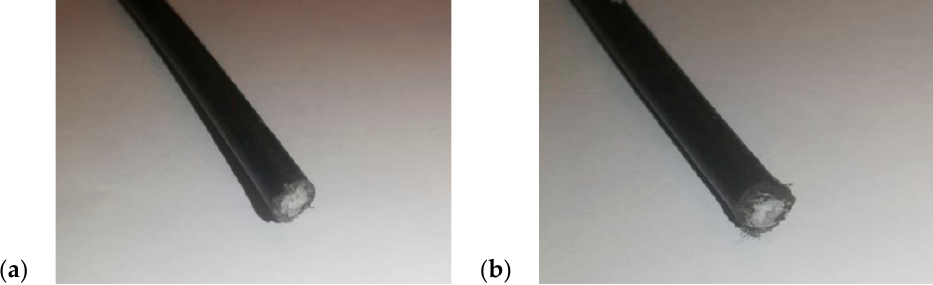
Figure 9. Waterjet cutting with abrasive examples for a push-pull spiral ( a ) and a braided spiral ( b